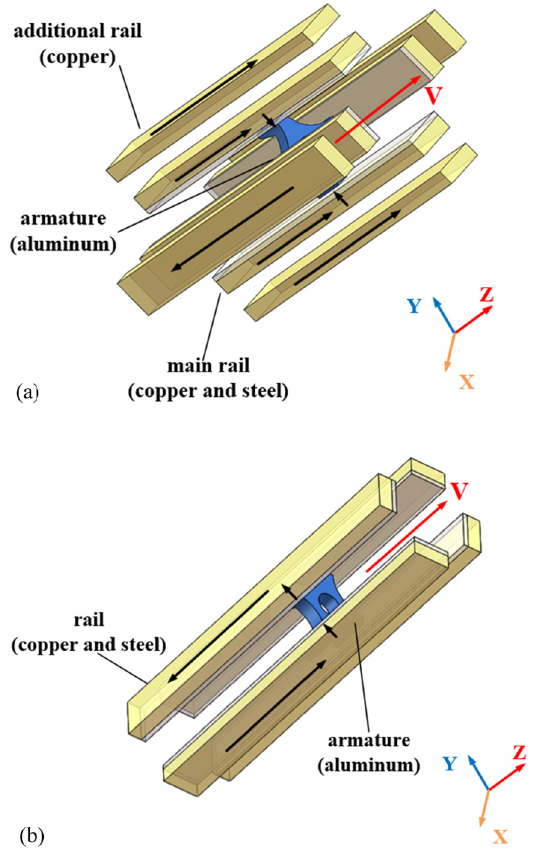
Figure 1: Models of the FRELs. ( a ) The proposed ECFREL and ( b ) the standard